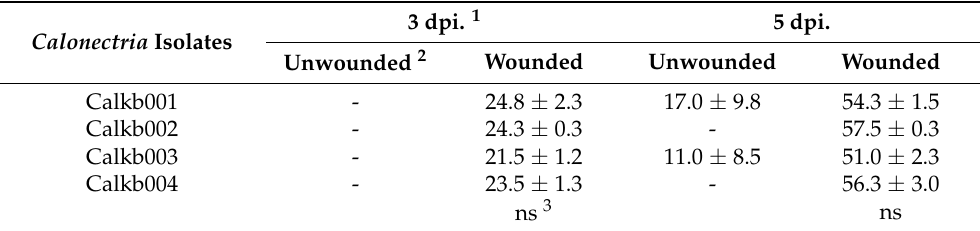
Table 1. Comparison of lesion size (mm) following inoculation of Calonectria on rubber tree leaves, unwounded and